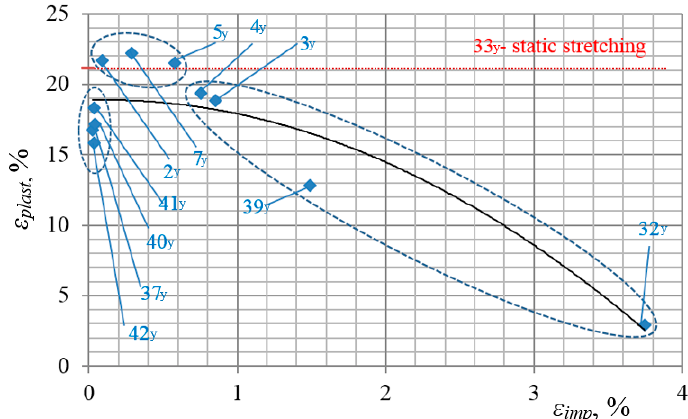
Figure 8. Dependence of plastic deformation of specimens from titanium alloy VT23 under static stretching ( ε plast ) on impulse deformation ( ε imp ), obtained under DNP.